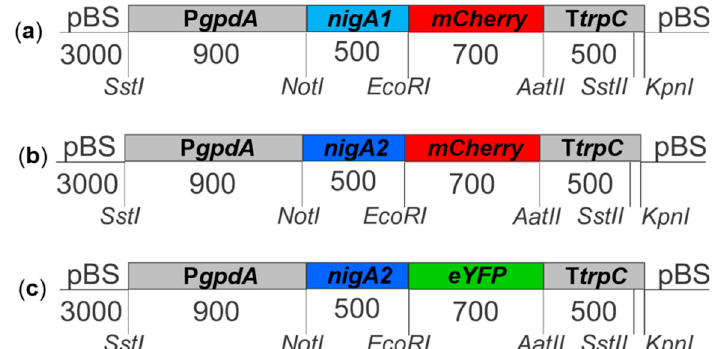
Figure 1. Schematic representation of expression cassettes for the transformation of the fungus A. niger strain N402. ( a ) nigA1 - mCherry ; ( b ) nigA2-mCherry ; and ( c ) nigA2-eYFP . Restriction enzyme cleavage sites are indicated. P gpdA , glycerol phosphate dehydrogenase A gene promoter from A. nidulans ; T trpC , tryptophan synthase C gene terminator from A. nidulans ; nigA1 , nigerolysin gene A1; nigA2 , nigerolysin gene A2; mCherry , gene for red fluorescent protein; eYFP , gene for enhanced yellow fluorescent protein; pBS, plasmid pBlueScript (Stratagen, USA). The numbers of base pairs indicate the size of the individual parts.